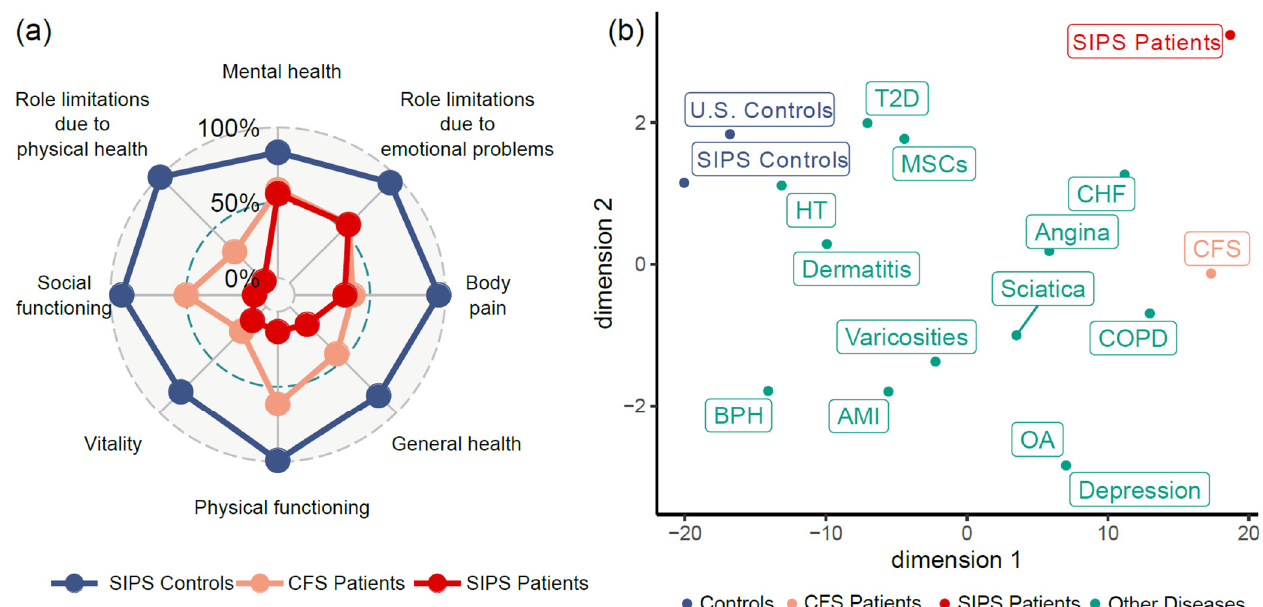
Figure 1. Comparison of the Quality of Life of Severely Ill myalgic encephalomyelitis/chronic fatigue syndrome (ME/CFS) and Other Major Diseases. ( a ) SF-36 scores of Severely Ill Patient Study (SIPS) patients, general CFS patients, and healthy controls. Compared with the general CFS patient population, scores on physical functioning (PF), role limitations due to physical health (RP), general health (GH), vitality/energy/fatigue (VT), and social functioning (SF) were significantly lower. ( b ) tSNE of SF-36 scores of SIPS, general CFS, and other medical conditions. T2D—type II diabetes, HT—hypertension, CHF—congestive heart failure, COPD—chronic obstructive pulmonary disease, MSCs—musculoskeletal complaints, BPH—benign prostatic hyperplasia, AMI—anterior myocardial infarction, and OA—Osteoarthritis. The quality-of-life scores of SIPS patients were clearly separated from that of controls, being most positively correlated with congestive heart failure (CHF) and most negatively correlated with clinical depression.